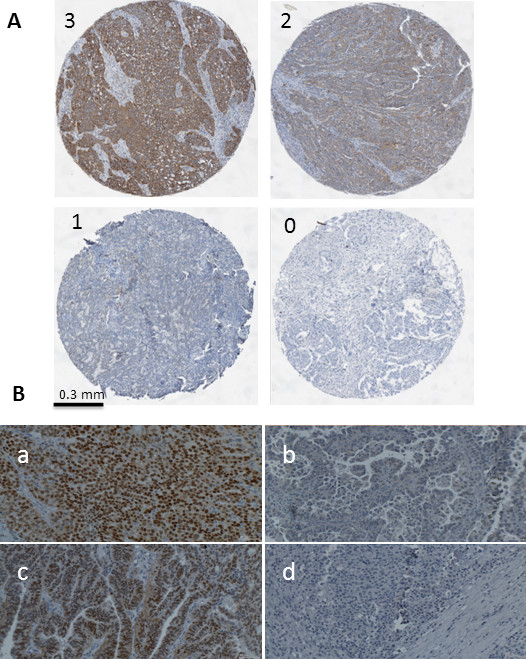
A) Representative immunohistochemical staining of TRAP1 in four different EOC samples classified as TRAP1 negative (0); weak (1); moderate (2); and strong (3); surrounding stromal tissue showed no TRAP1 staining; B) Staining of ERα (a, c) highly positive (strong intensity of nuclear staining, >80% positive nuclei), (b) <10% of nuclei show weak staining, and (d) completely negative for nuclear ERα staining, were scored as ERα negative. Pictures were taken using TissueFAXS (TissueGnostics; Vienna, Austria).